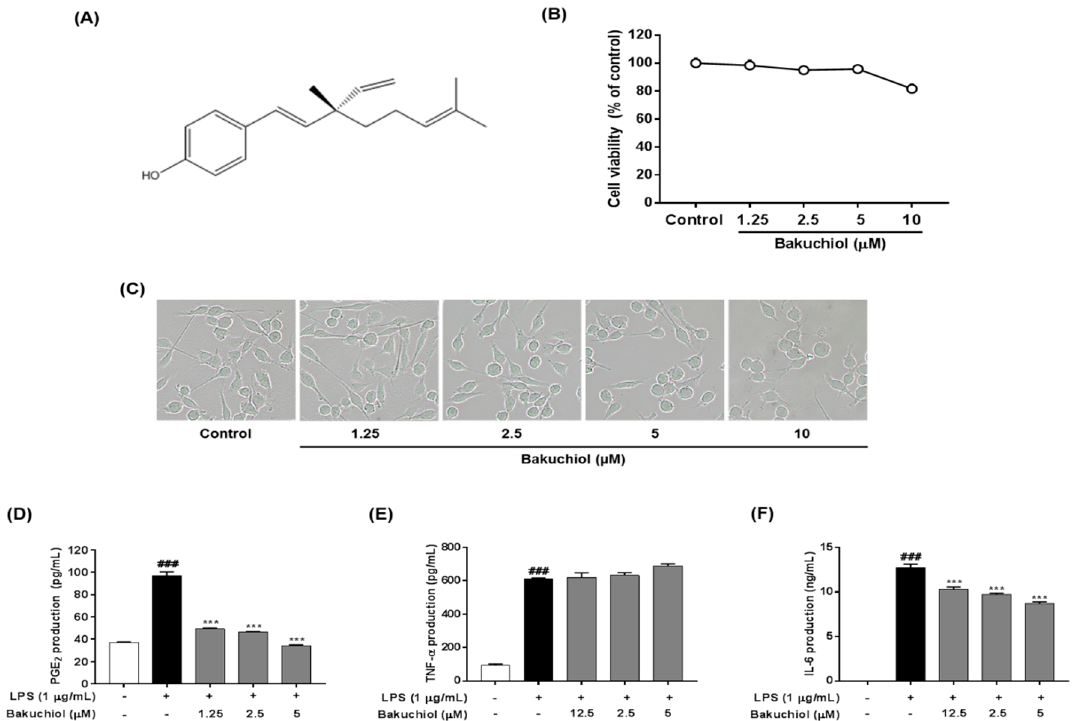
Figure 1. Cytotoxicity and effects of bakuchiol on lipopolysaccharide (LPS)-stimulated prostaglandin E 2 (PGE 2 ), tumor necrosis factor- α (TNF- α ), and interleukin-6 (IL-6) production of bakuchiol in BV-2 microglia. Chemical structure of bakuchiol ( A ). Cells were seeded on 96-well plates and treated with various concentrations (0, 1.25, 2.5, 5, or 10 μ M) of bakuchiol for 24 h ( B ). Cell viability was assessed using the CCK-8 assay. Morphological assessment after bakuchiol treatment. Images are shown from cells treatment 24 h to 0, 1.25, 2.5, 5, or 10 μ M bakuchiol ( C ). Photomicrographs were taken under a standard light microscope at 20× magnification. The production of PGE 2 ( D ), TNF- α ( E ), and IL-6 ( F ) was measured in the culture medium and assessed using enzyme-linked immunosorbent assay (ELISA). The results are expressed as the mean ± SEM of three independent experiments. ### P < 0.001 vs. untreated control cells and *** P < 0.001 vs. LPS-treated cells.